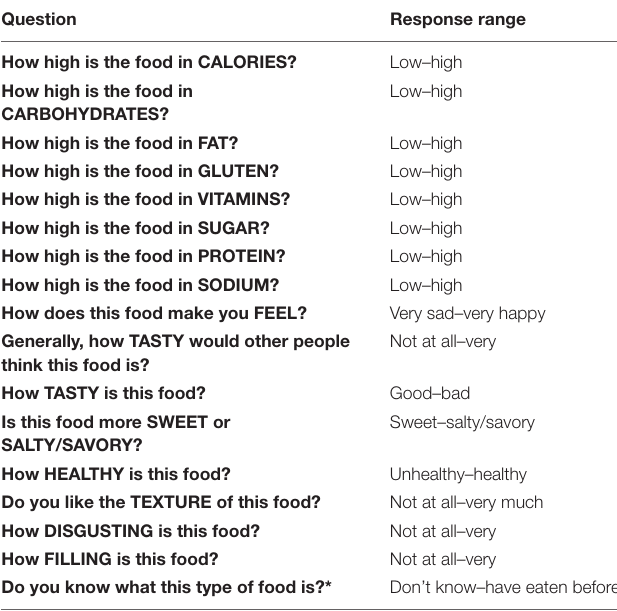
TABLE 1 | Rating task questions and response